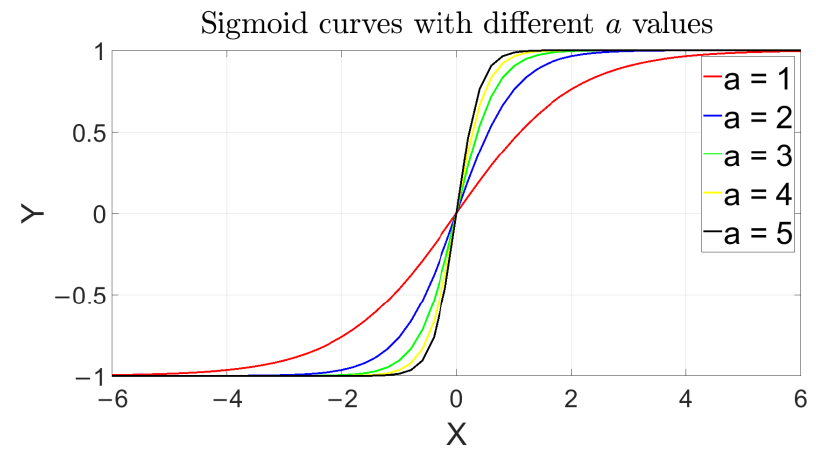
Figure 4. Sigmoid activation function used in the BPNN, where a is taken as 1 for practice in this study (i.e., shown in the red line).